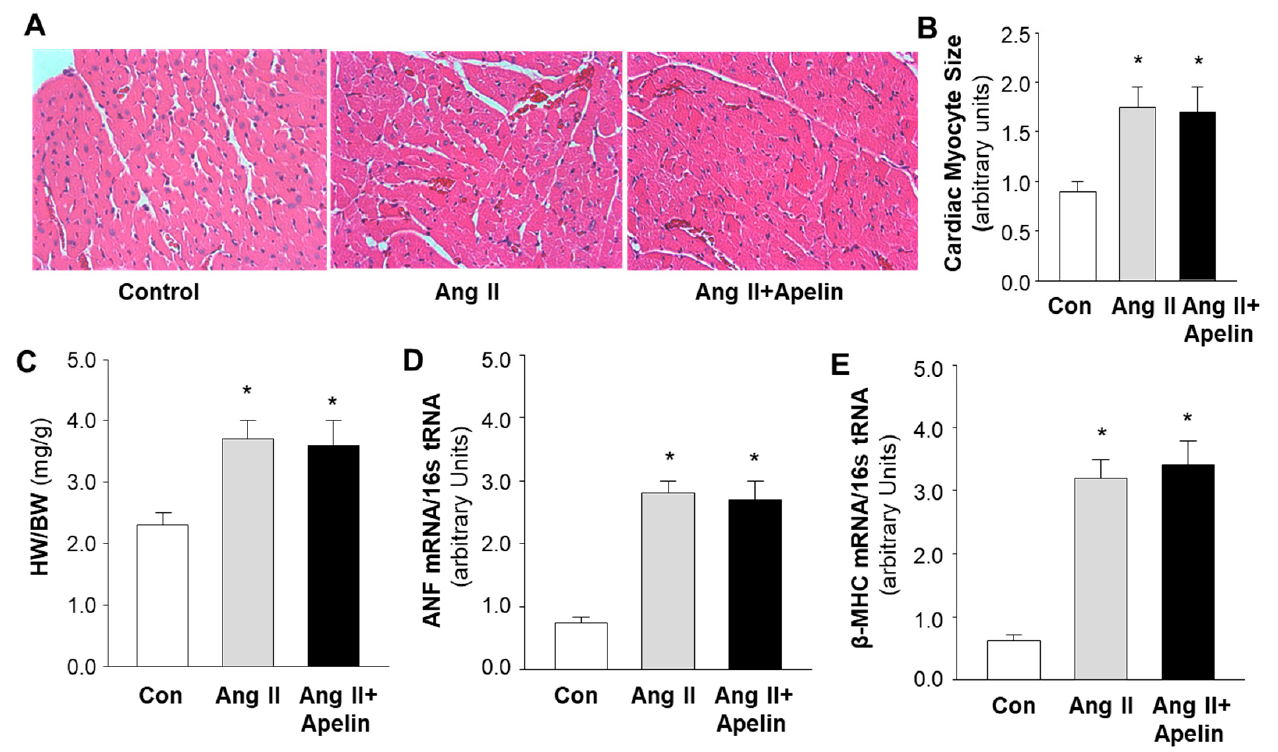
Figure 4. Effect of chronic subcutaneous infusions of apelin and Ang II on cardiac morphology and expression of hypertrophy-related genes. The cardiac histology and gene expression were examined using hematoxylin and eosin (H&E) staining and real-time PCR, respectively, in rats that were treated with saline, Ang II, or Ang II plus apelin, as described in the Methods. ( A ), micrographs (magnification, 20X) showing representative heart sections stained with H&E in rats that received subcutaneous infusions of saline, Ang II, or Ang II plus [pyr 1 ]-apelin-13 through osmotic minipumps, as described in the Methods. ( B ), bar graphs summarizing the cardiac myocyte area within the cardiac sections in each group of rats. ( C – E ), bar graphs showing the ratio of heart weight versus body weight (HW/BW) ( C ), mRNA levels of atrial natriuretic factor (ANF) ( D ), and beta myosin heavy chain ( β -MHC) ( E ), measured using real-time PCR in the heart of rats that received subcutaneous infusion of saline, Ang II, or Ang II plus apelin-13. Data are expressed as means ± SE ( n = 6 rats in each group). Significance was set as p < 0.05 (*), comparing with saline control.